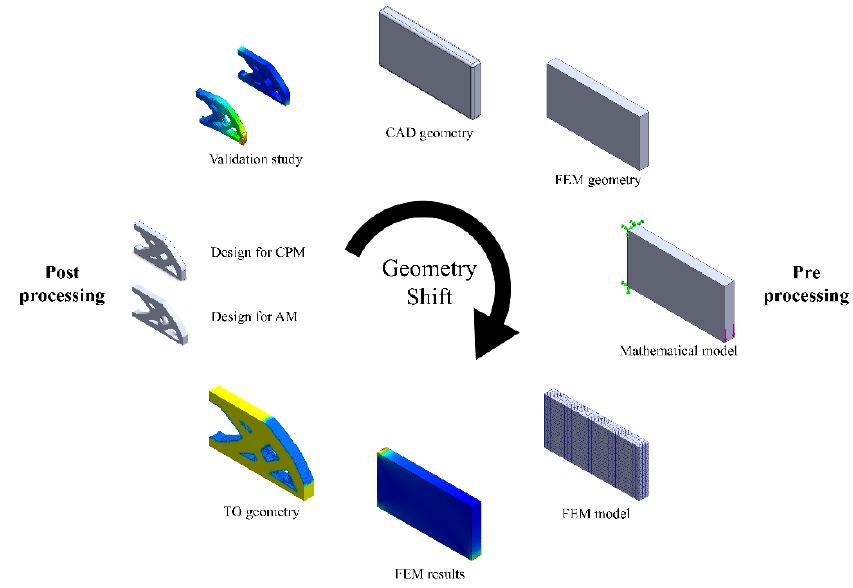
Figure 2. A common TO workflow adapted from [11] .